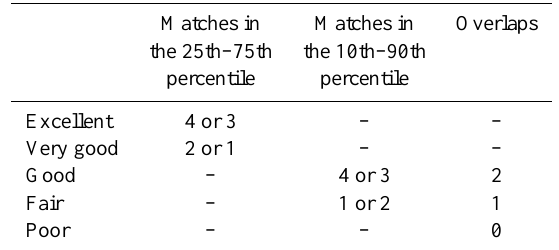
Table 2. Measure of model performance using data obtained from a box and whisker plot. A “match” is defined as a model (observa- tion) median or mean being in between the two percentiles of the observation (model) distribution. Matches ranges from 4 (perfect match) to 0 (no match). An “overlap” is defined as when mod- eled and observed inner quartiles (boxes) or inner deciles (whiskers) overlap. Overlaps ranges from 2 to 0. The final performance is assigned as the best of the three